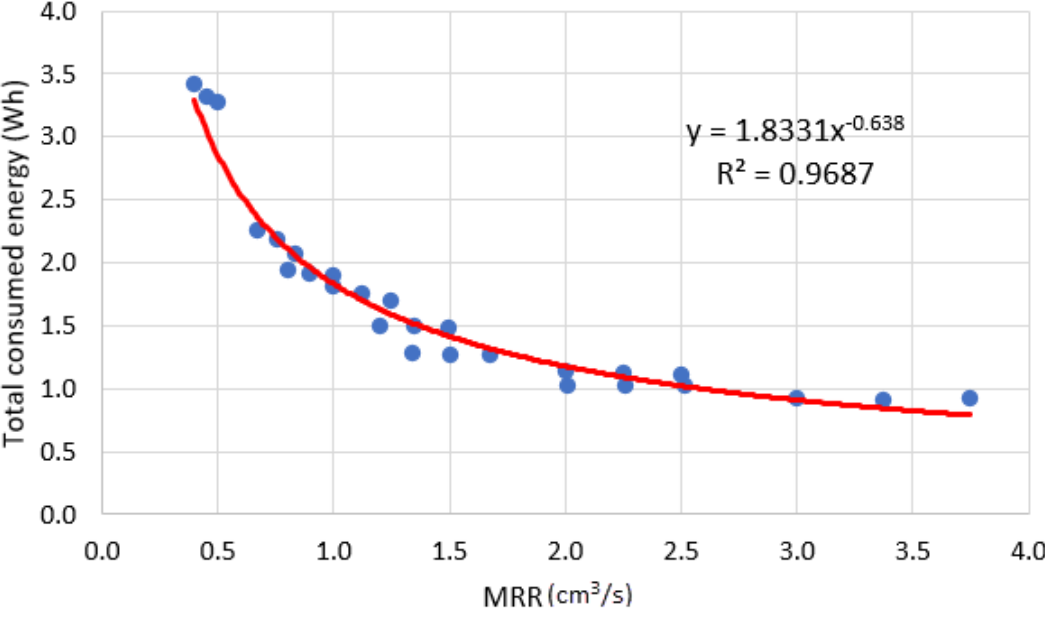
Figure 16. Total energy consumption as a function of MRR (material volume removal rate is given in cm 3 , 1 cm 3 = 10 3 mm 3 ).